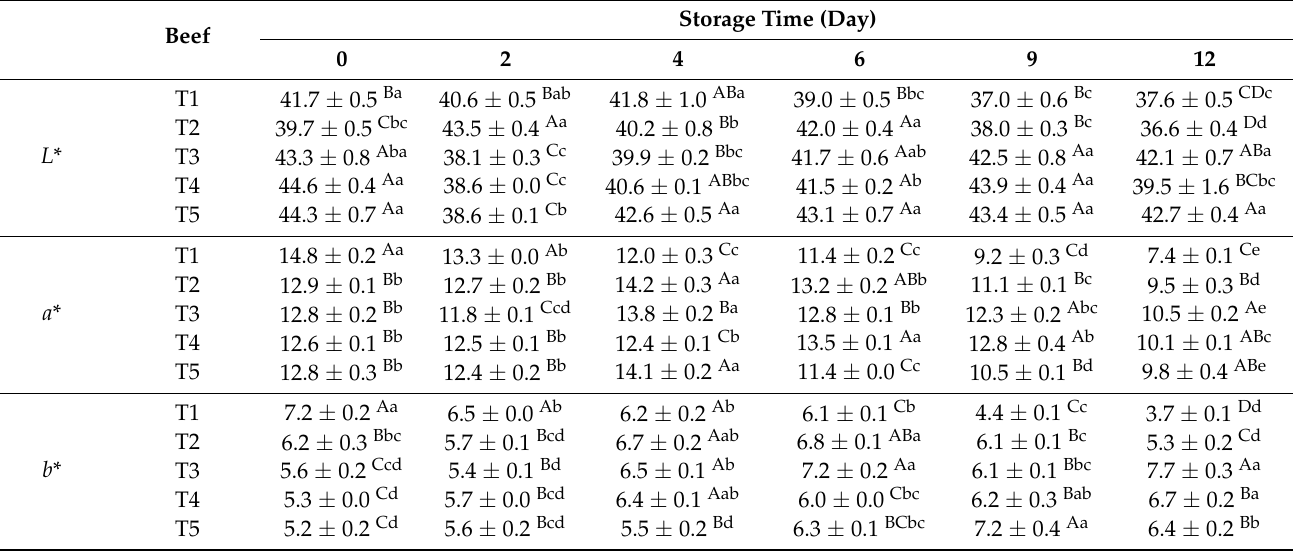
Table 1. The color of beef samples from different treatment groups during storage (mean ±